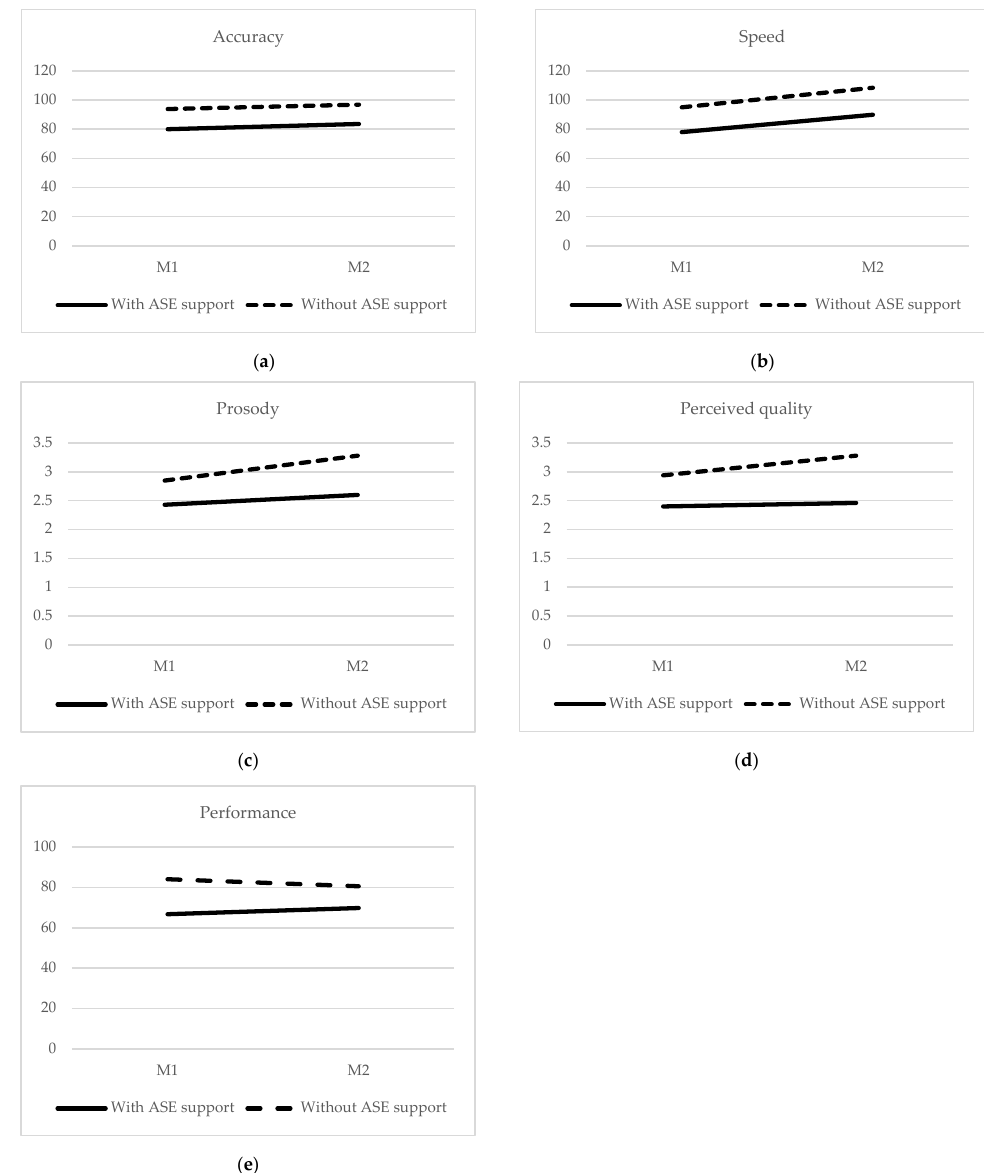
Figure 1. Graphics ( a – e ) show the differences between participants with and without ASE support between June and November. ( a ) Results for accuracy measured in June (M1) and in November (M2) for participants with and without ASE support. ( b ) Results for the speed measured in June (M1) and November (M2) for participants with and without ASE support. ( c ) Results for prosody measured in June (M1) and November (M2) for participants with and without ASE support. ( d ) Results for perceived quality measured in June (M1) and in November (M2) for participants with and without ASE support . ( e ) Results for performance measured in June (M1) and in November (M2) for partici ‐ pants with and without ASE support.